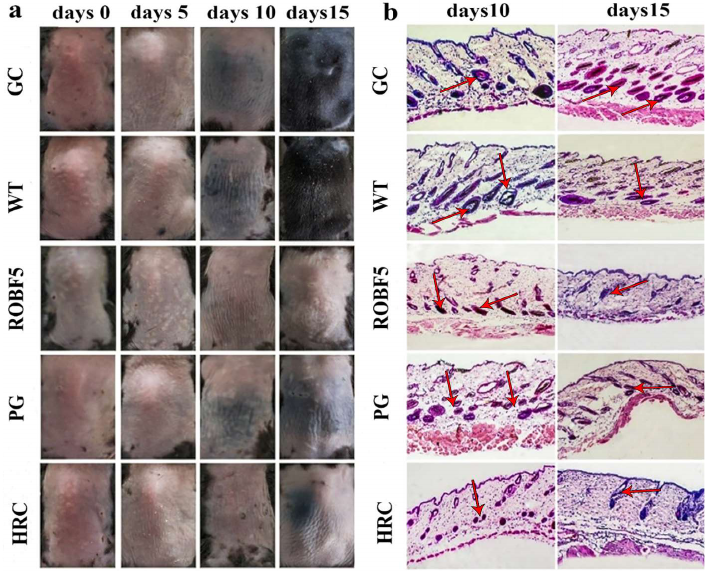
Figure 3. Effect on inhibiting hair growth by recombinant oil body expressing hFGF5 in vivo. ( a ) Hair regeneration on the back of mice in 15 days after administration (n = 6). ( b ) Pathological analysis by H&E staining on day 10 and day 15 (magnification 100 times). CG: Control group (PBS), WT: wide-type oil body, PG: positive group (hFGF5), ROBF5: recombinant oil body expressing hFGF5, HRC: hair retardant cream (Red arrows show the staining).